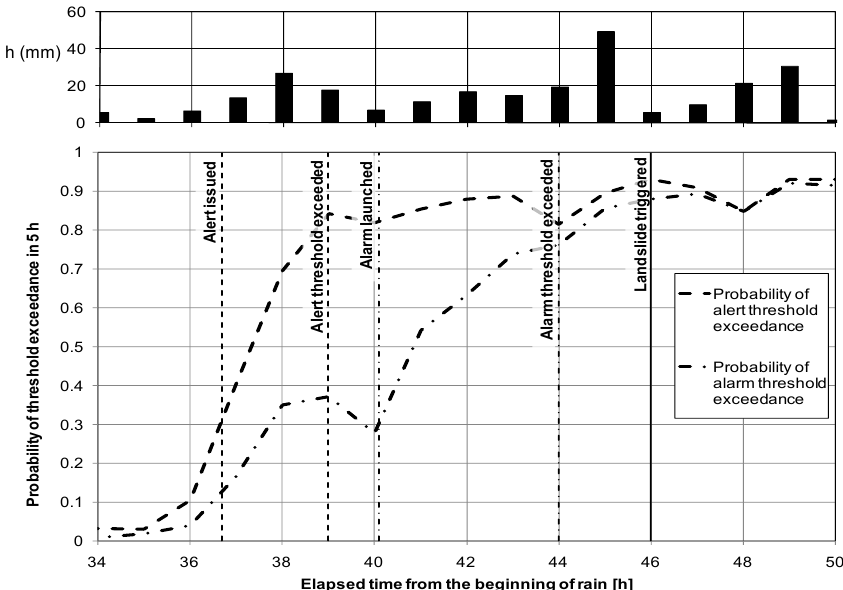
Elapsed time from the beginning of rain [h] Figure 5. Stochastic approach to early warning: probability of exceeding alert and alarm thresholds of the mobility function at the slope of Pessinetto, predicted in real time (the upper panel reports the observed hyetograph) during the storm of 12.10.2000, when an earth flow occurred 46h after the beginning of the rain.